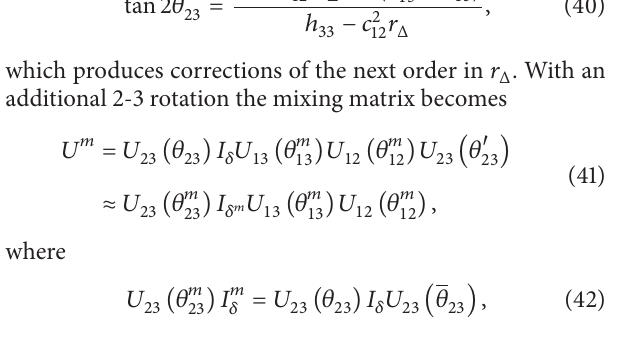
Figure 1: Resonance in neutrino mixing. The dependence of sin 2 2𝜃 𝑚𝑖𝑗 on the product 𝑉𝐸 for vacuum mixing: sin 2 2𝜃 12 = 0.851 , Δ𝑚 2 21 = = 0.0241 , Δ𝑚 2 = 2.47⋅10 −3 eV 2 (green). The left semiplane corresponds to antineutrinos. The behavior of 𝜃 7.59⋅10 −5 eV 2 (red) and sin 2 𝜃 13 31 with vacuum value sin 2 2𝜃 23 = 0.953 is included for completeness. The dashed lines are the predictions from a strict two-flavor approximation while the solid thin lines are the results of numerical diagonalization of the full three-flavor system. The upper panels show the case of the normal mass hierarchy and the lower panels show the inverted